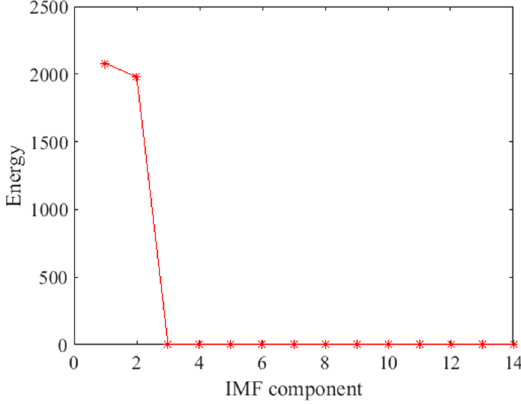
Figure 9. The energy of each IMF component and residue.